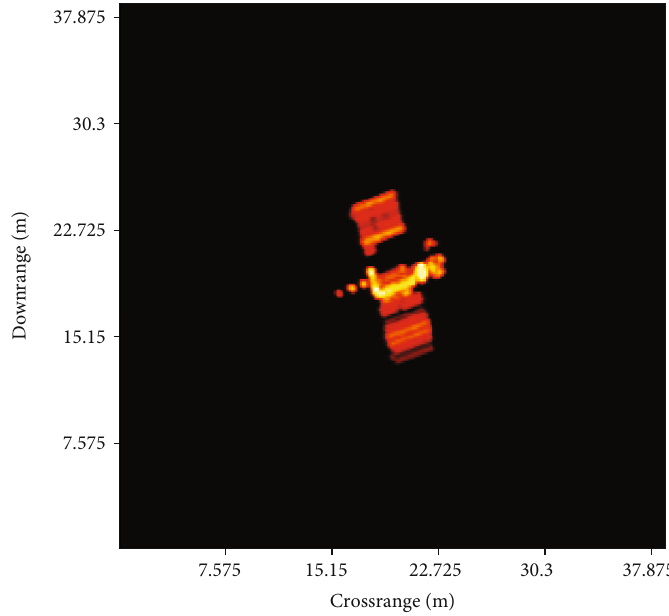
Figure 1: ISAR image of the target